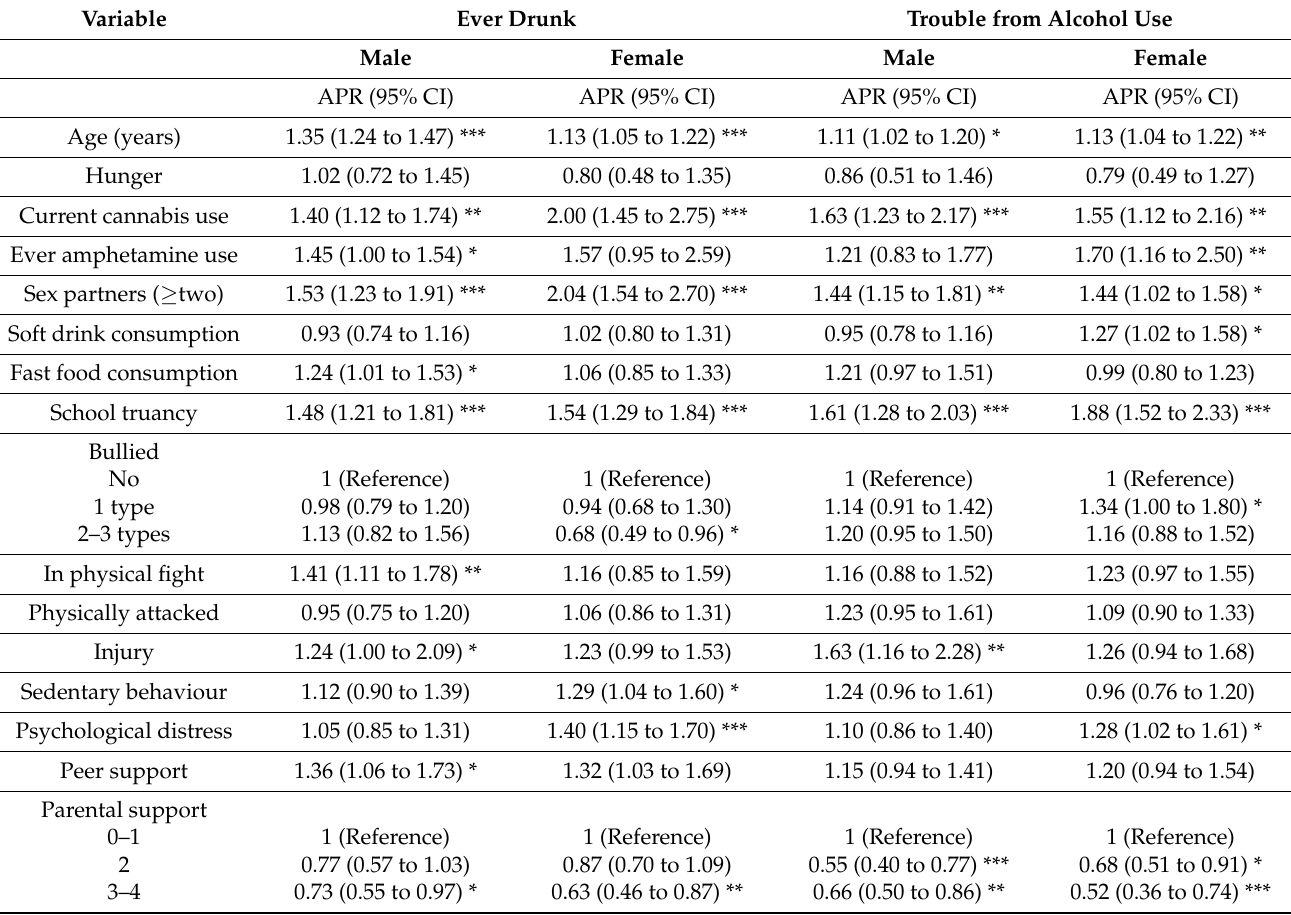
Table 4. Associations with lifetime drunkenness and trouble from alcohol use by